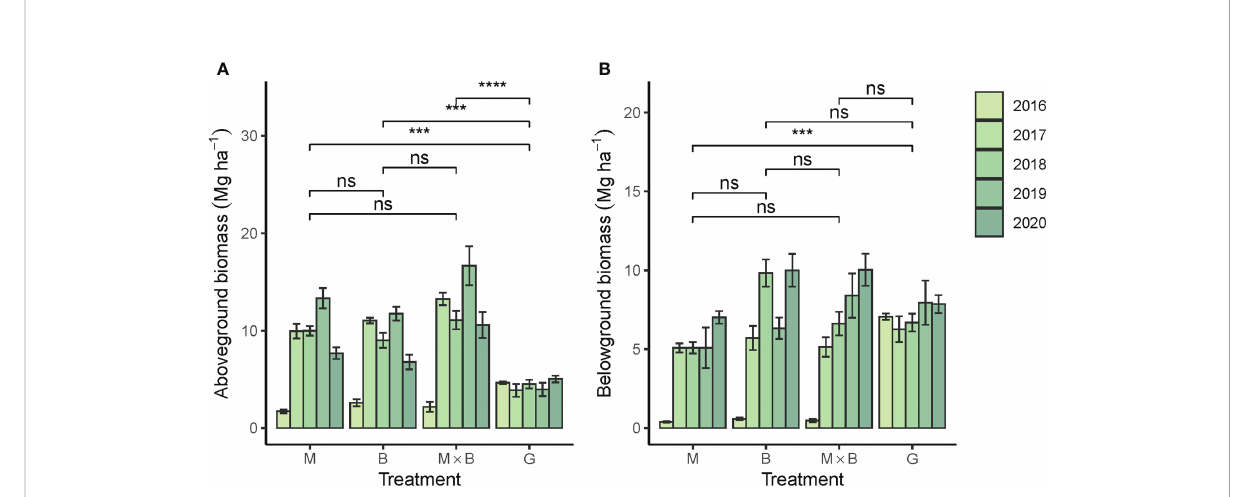
FIGURE 7 Year-to-year variations in above- and belowground biomass production of the alfalfa (M), smooth bromegrass (B) monocultures and the M×B mixture in comparison with a natural grassland (G) during the experimental period from 2016 to 2020. (A) , aboveground biomass production; (B) , belowground biomass production in 0-10 cm soil layer. Bars and whiskers represent y ̄ ± s M . *** p < 0.001, **** p < 0.0001, ns p >